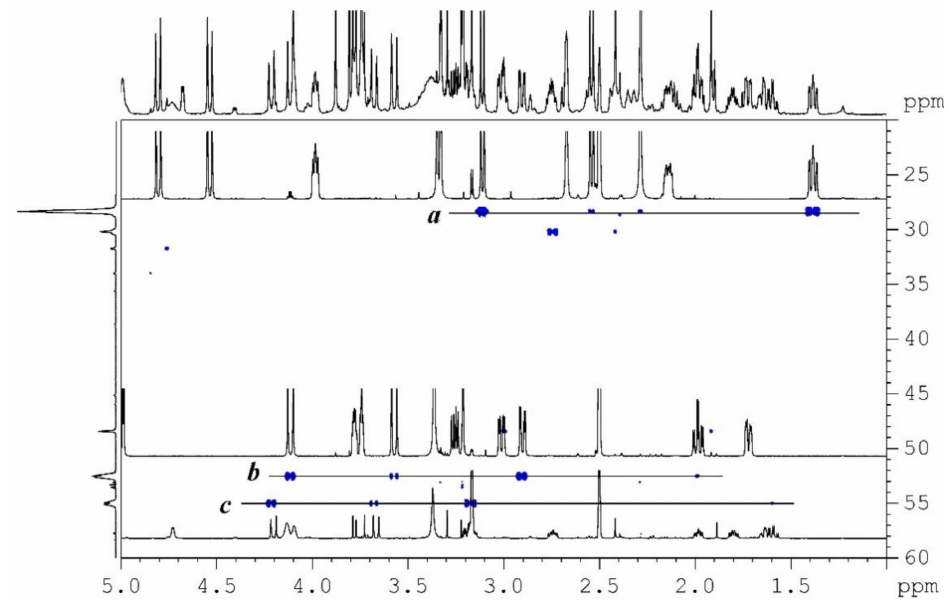
Figure 3. The 1 H- 15 N HMBC spectrum of extract 3. The projection on the 15 N chemical shift axis provides of rough estimation of extract complexity. Traces a , b , and c are the 1 H-NMR spectra of tazettine, haemanthamine, and crinine recorded from fractions A4, A9, and A11,